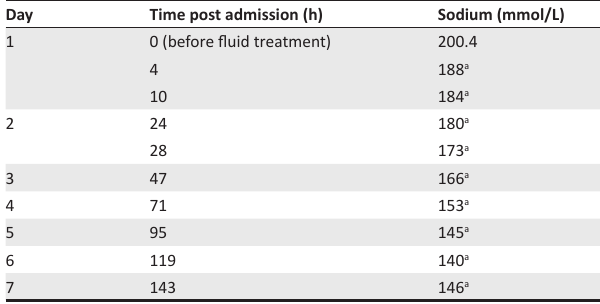
TABLE 4: Changes in sodium